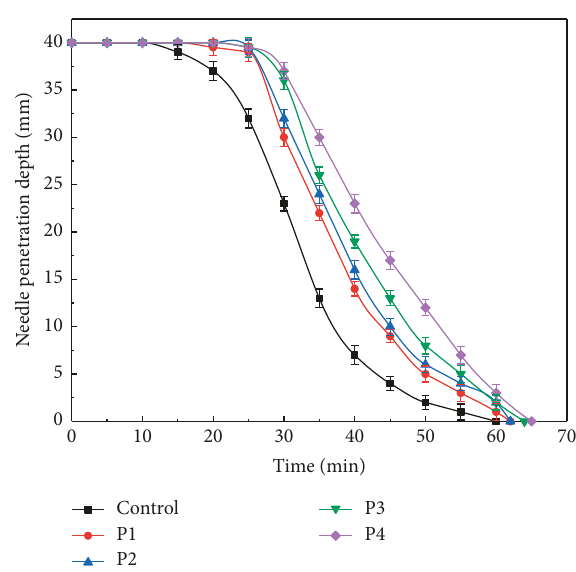
Figure 4: Evolution of the setting time of AAS mortars as function of PPF content. The error bars represent the standard deviation of three test